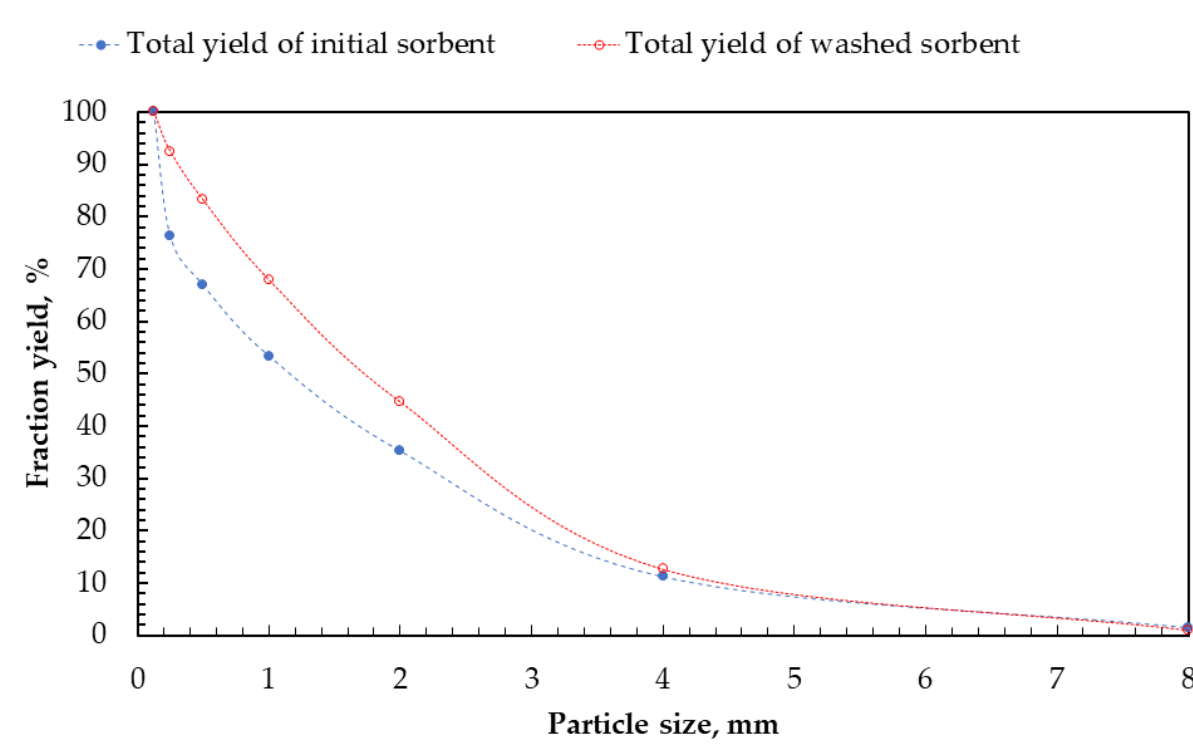
Figure 3. Material size characteristics.